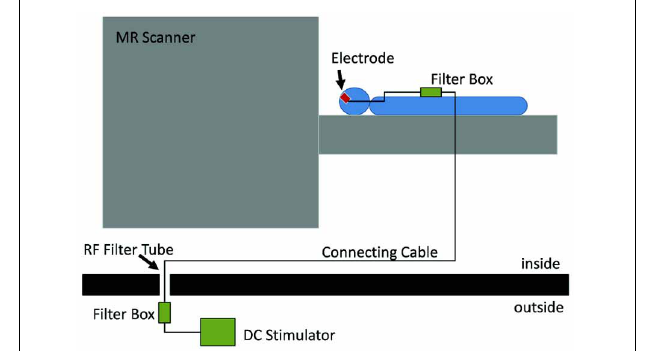
FIGURE 2 | Experimental setup which allows stimulation inside the scanner and also concurrently with fMRI. The electrodes on the subjects’ head are connected to a filter box, itself connect by a cable going through the wall of the scanner room. This cable is connected to another filter box, to which the stimulator is connected. Reprinted from Antal et al. (2011), with permission from